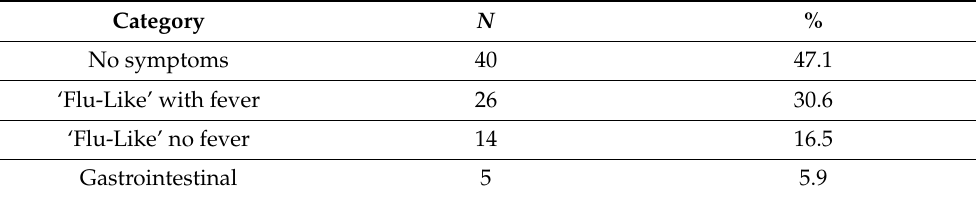
Table 2. Symptoms classification in SARS-CoV-2 vaccinated participants.